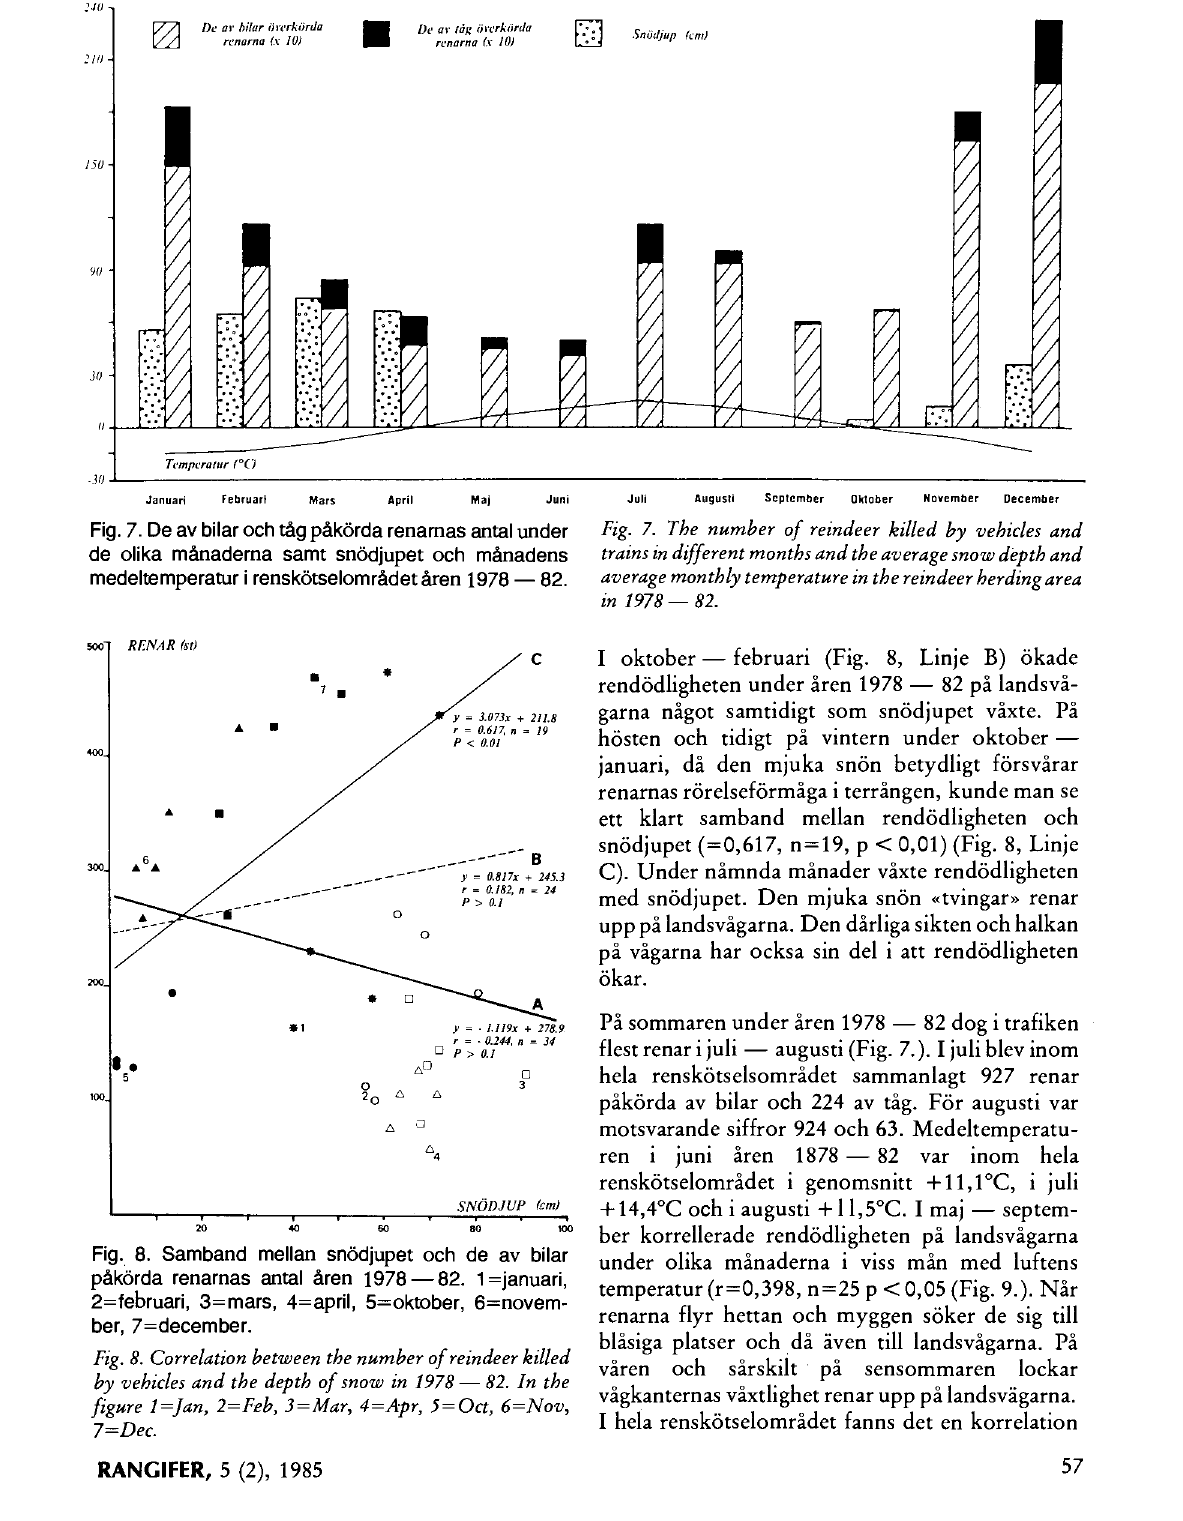
Fig. 8. Correlation between the number of reindeer killed by vehicles and the depth of snow in 1978 — 82. In the figure l=Jan, 2=Feb, 3=Mar, 4=Apr, 5=Oct, 6=Nov,